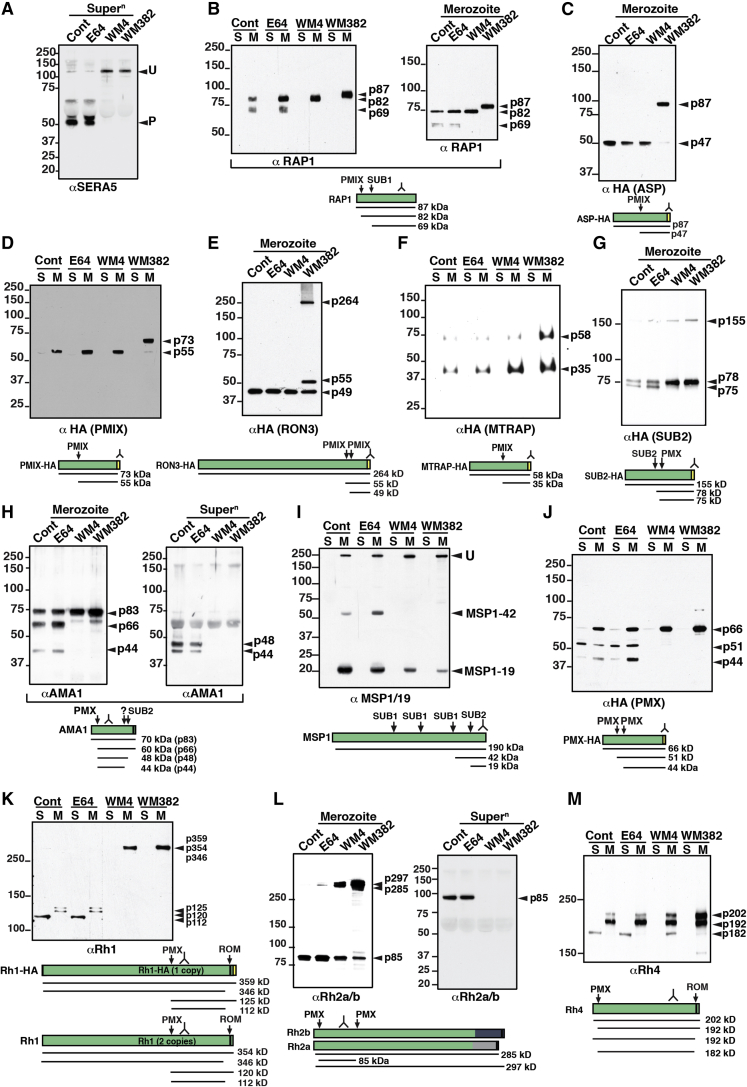
PMIX and PMX Process Invasion Proteins(A) SERA5 processing inhibited by WM4 and WM382.(B) RAP1 processed by PMIX and SUB1 (left) and separated further for merozoites (right).(C) Merozoites probed with αASP inhibited by WM382.(D) PMIX autocatalytically processed and inhibited by WM382.(E) RON3 processing inhibited by WM382.(F) MTRAP processing inhibited by WM382.(G) SUB2 processing by PMX.(H) αAMA1 detection after treatment with E64, WM4, and WM382. Left: merozoites. Right: supernatant.(I) MSP1 detection (αMSP1/19) from merozoites treated with E64, WM4, and WM382.(J) PMX autocatalytically processed and inhibited by WM4 and WM382.(K) Rh1 processed by PMX. W2mef-HA parasites have three Rh1 genes with one HA tagged.(L). Rh2a/b are processed by PMX. Left: merozoites. Right: supernatants. Rh2a and Rh2b are identical but differ at C terminus (blue and gray domains).(M) Rh4 (αRh4) processed by PMX.A summary schematic for each protein is shown (HA-tag, yellow box; transmembrane, black box. Supernatants (Supern or S) released from merozoites. M, merozoites. Position of detecting antibody signified by . Molecular weight kDa.